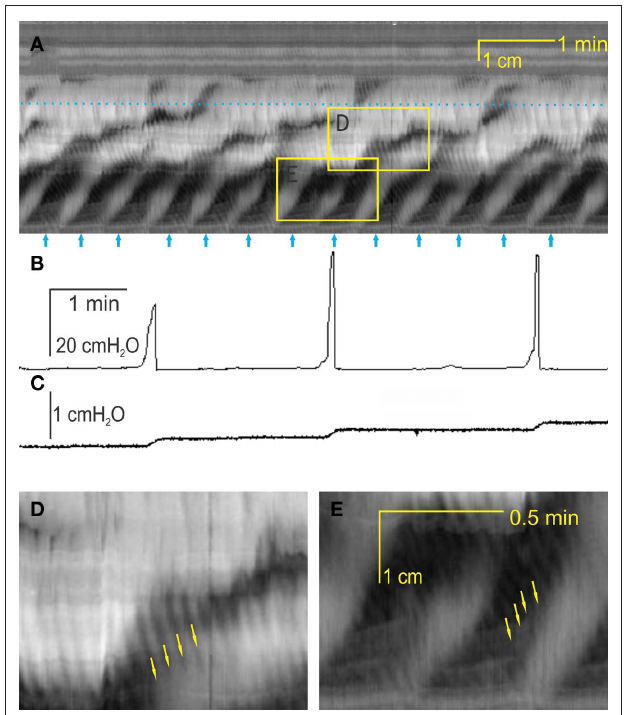
FIgurE 1 | Two motor patterns, intraluminal pressure changes, and outflow. (A) A spatiotemporal map of rat colonic motility (circular muscle activity) over a 20-min period. Black is narrowing of the lumen, hence circular muscle contraction and white is relaxation or widening of the lumen. For each map, the Y-axis is distance along the colon (proximal colon = bottom third, mid colon = middle third, distal colon = top third); the X-axis is time. Thirteen rhythmic propulsive motor complexes are seen to propagate anally in the proximal colon [arrows underneath (A) ] and some are continuing to propagate into the mid colon at decreased velocity. Within these motor complexes, rhythmic propagating ripples occur at a much higher frequency and propagate in a different direction [arrows in (D,E) ]. The dotted line in (A) indicates the position of the intraluminal pressure transducer. The rhythmic propulsive motor complexes in the mid colon are accompanied by strong increases in intraluminal pressure (B) and outflow of content (C) , measured simultaneously. The outflow (C) was collected in a cylinder and measured as increase in pressure measured at the bottom of the cylinder. (D) Enlargement of box in the mid colon. (E) Enlargement of box in the proximal